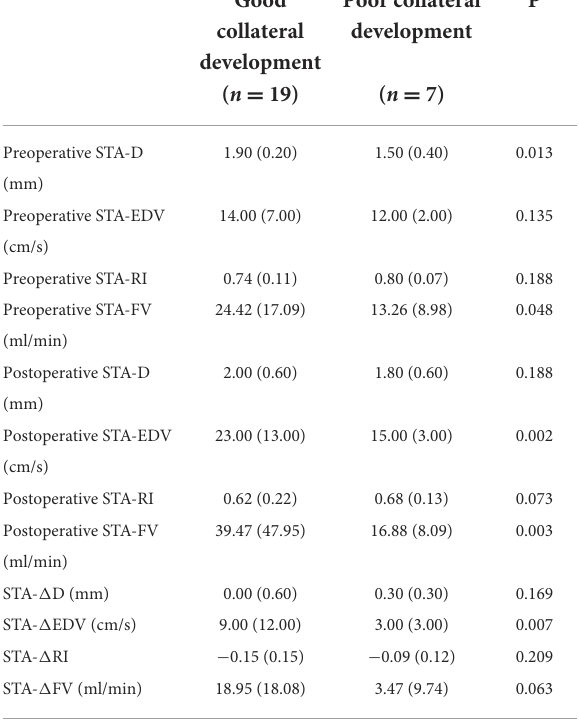
TABLE 4 Differences in STA ultrasound parameters between good and poor collateral development groups after STA-MCA